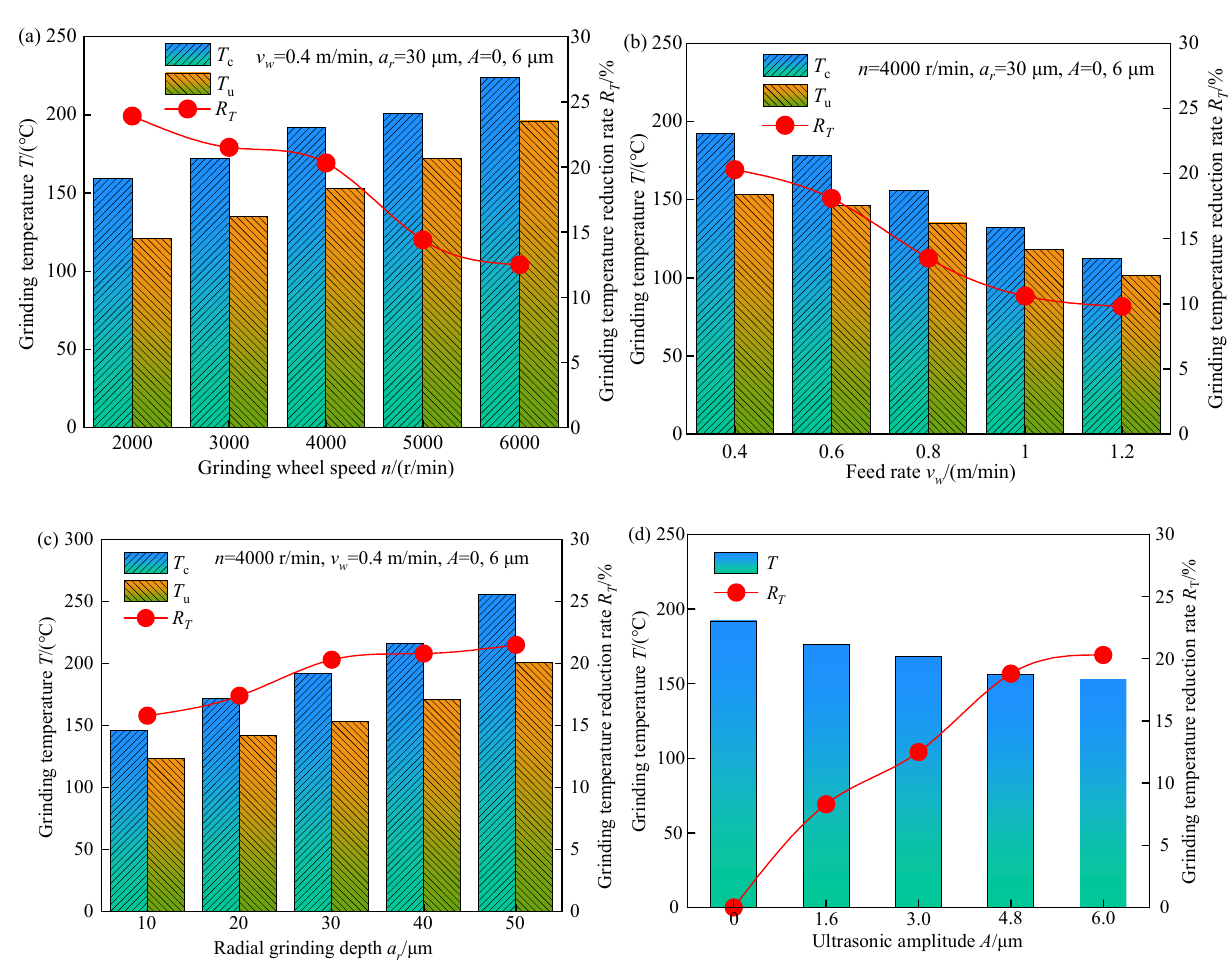
Figure 3. Effects of processing and ultrasonic parameters on the grinding temperature: ( a ) grinding, wheel speed, ( b ) feed rate, ( c ) radial grinding depth, and ( d ) ultrasonic